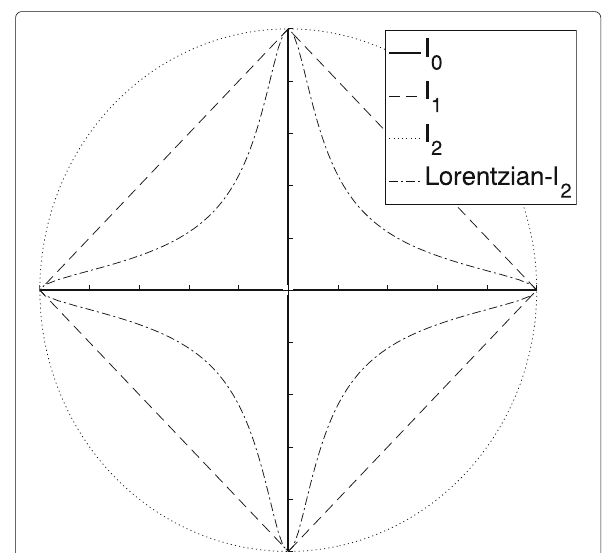
Fig. 3 Contours of several norm regularizations are discussed